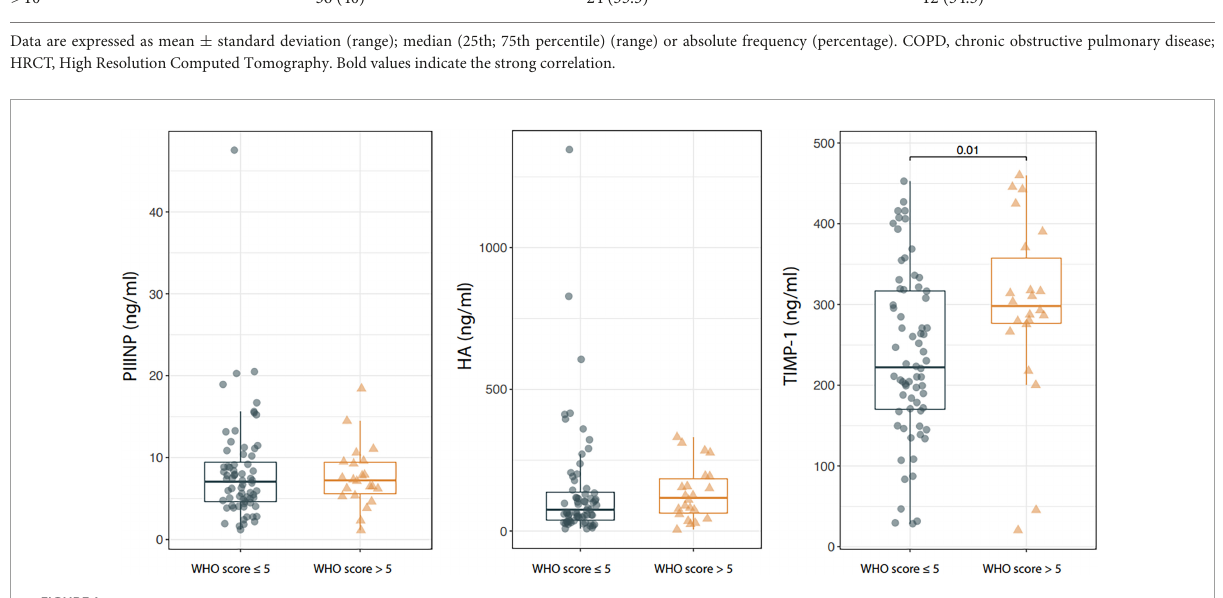
FIGURE1 Box-plot showing serum procollagen type III amino terminal propeptide (PIIINP), Hyaluronic acid (HA), and tissue inhibitor of metalloproteinases 1 (TIMP-1) levels in patients with Coronavirus Disease 2019 (COVID-19) stratified according to the WHO score at baseline. Boxes are defined by Q1, Median (bold line) and Q3. Whiskers reach the minimum and the maximum of the distribution except for the presence of outliers, defined as data points below Q1–1.5*IQR or above Q3 + 1.5*IQR. To avoid overlapping a small amount of horizontal jitter was added. Q1, First quartile; Q3, Third quartile; IQR =